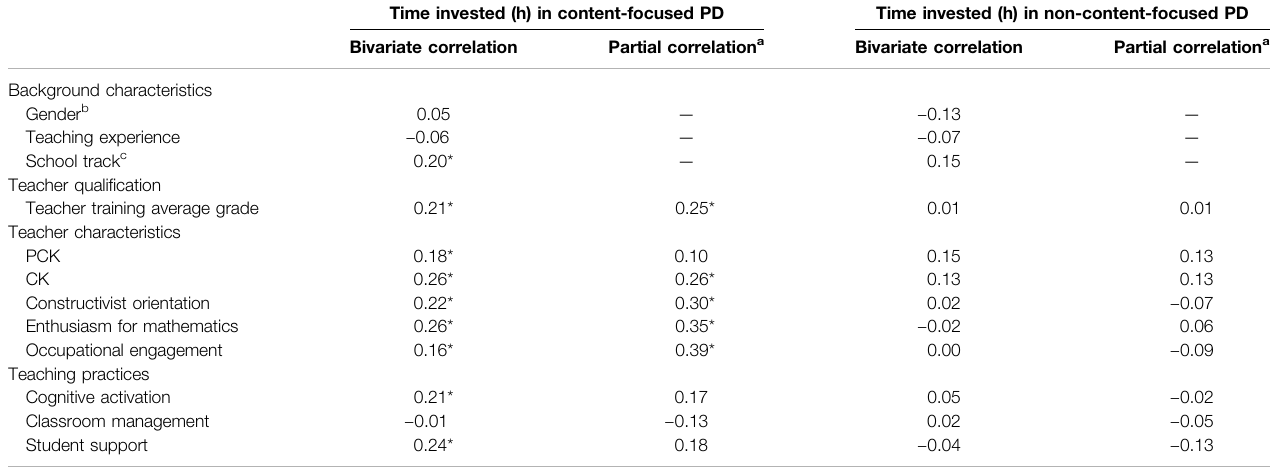
TABLE 1| Bivariate and partialcorrelationsbetweenteachers ’ backgroundcharacteristics(gender,teaching experience,schooltrack),teachers ’ professional competence, and the time (h) teachers invested in content-focused and non-content-focused PD activities. Time invested (h) in content-focused PD Time invested (h) in non-content-focused PD Bivariate correlation Partial correlation